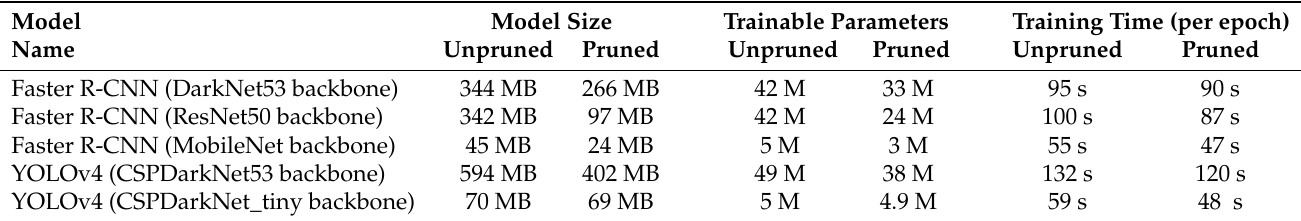
Table 3. Impact of pruning on the computer vision object detection models trained for the automated plastic-bag contamination detection.